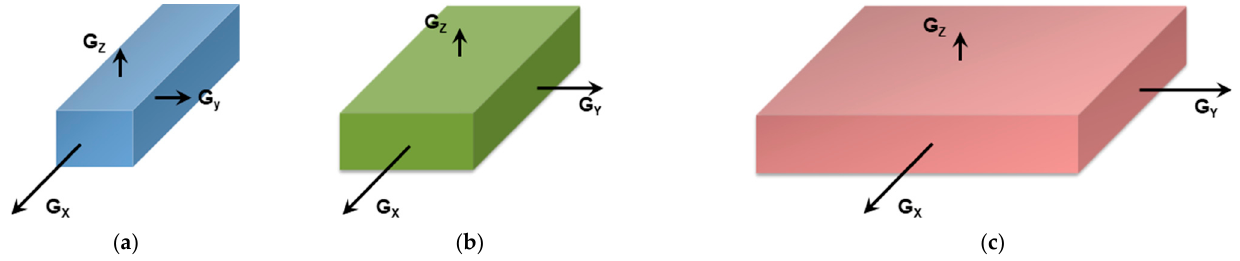
Figure 3. ( a ) fibrillary shape due to the fact that the growth rate along the x-direction, G x , is much faster than those in the other two directions (G x >> G y and G x >> G z ). ( b ) formation of a lath when G x > G y >> G z ; ( c ) when G x = G y >> G z , then formation of extended platelets is expected.